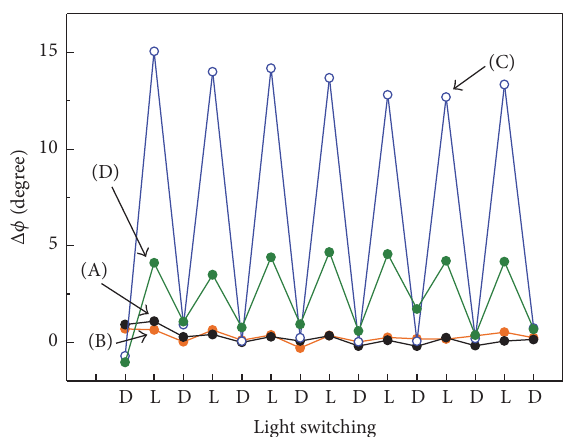
Figure 8: Changes in Δ𝜙 of an MFM tip set 4 nm above spots (A), (B), (C), and (D) as in Figure 6 under chopped light